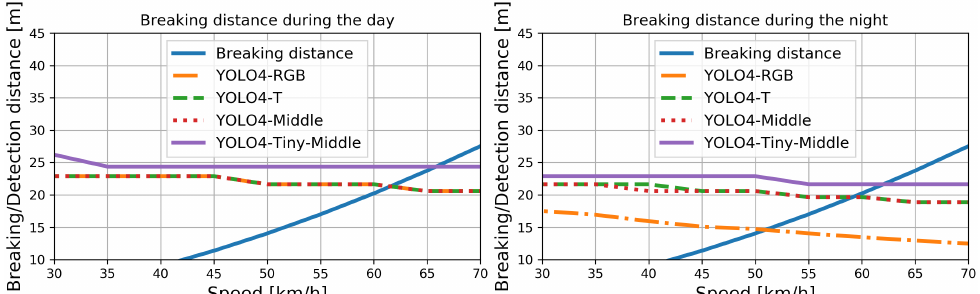
Figure 12. Detection distances for each method when a person can be detected with a probability exceeding 0.99. We show the typical braking distance, proving that the system can perform emergency braking when the speed does not exceed 50